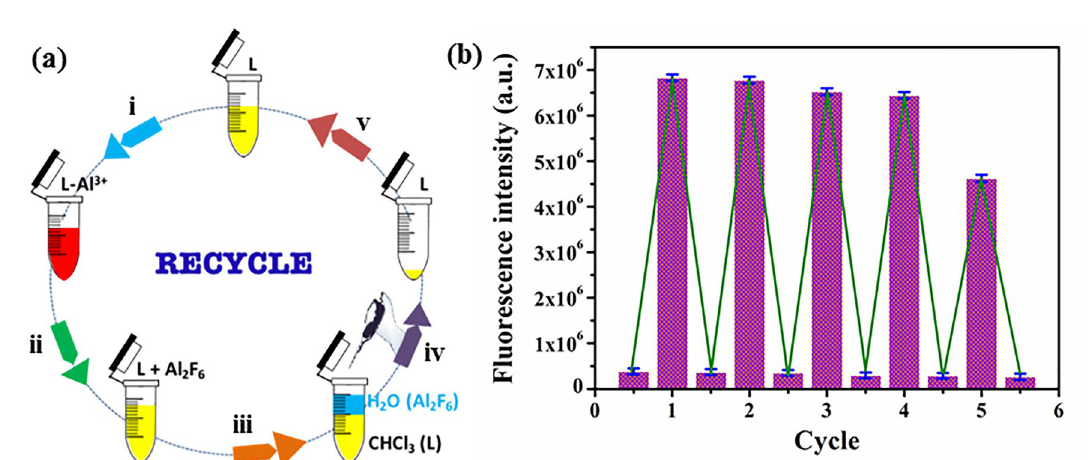
Figure 10. ( a ) Schematic representation of the recycle experiment (i) addition of Al 3+ to the receptor L, (ii) addition of fluoride, (iii) extraction of organic layer with chloroform, (iv) removal of aqueous layer and drying of organic layer, (v) dissolve the crude in acetonitrile; ( b ) Recyclability of the probe L toward